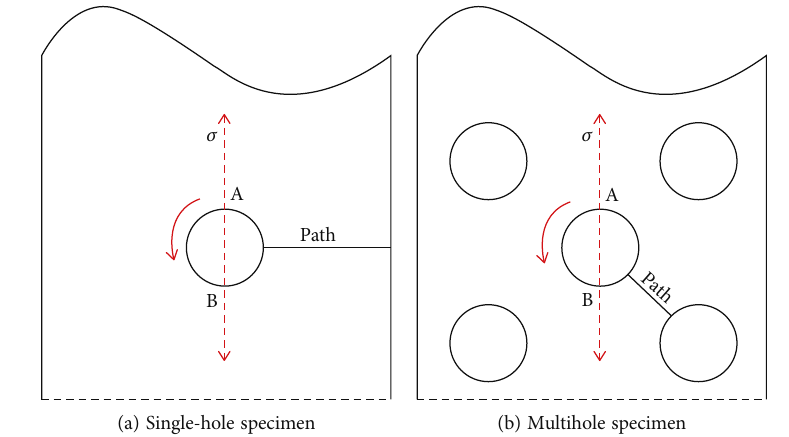
Figure 9: Dangerous path of the simulation results.